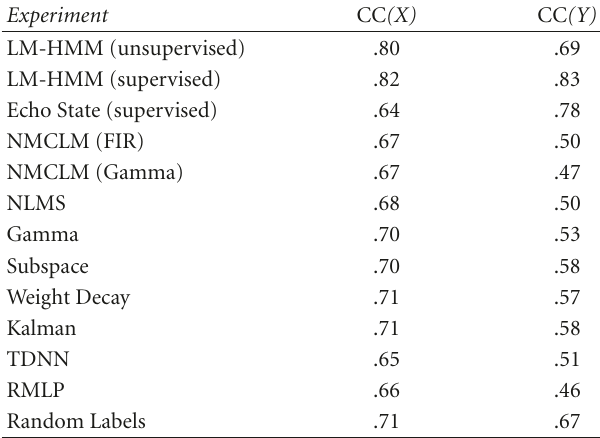
Table 1: Correlation coe ffi cient using LM-HMM on 2D monkey